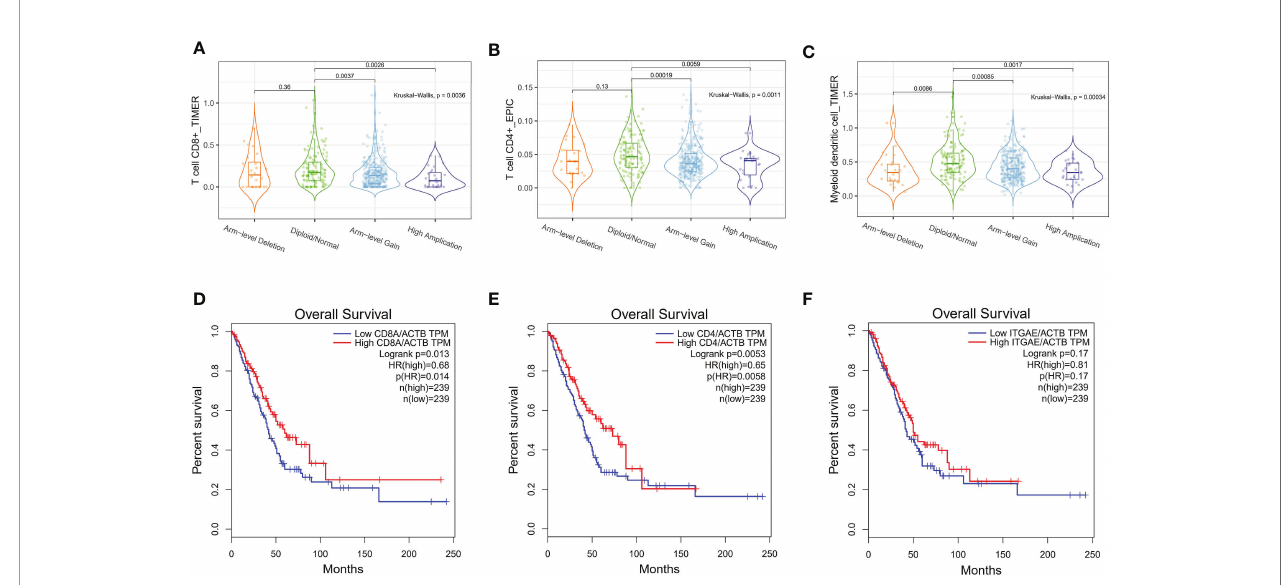
FIGURE 2 | LINC00467 DNA copy number alterations correlate with immune cell in fi ltration in LUAD. The correlation between LINC00467 DNA copy number alteration and the in fi ltration levels of CD8 + T cells (A) , CD4 + T cells (B) , and dendritic cells (DC) (C) in LUAD. The overall survival of patients with low versus high in fi ltration levels of CD8 + T cells (D) , CD4 + T cells (E) , and DC cells (F) . ITGAE is a marker of DC cells.